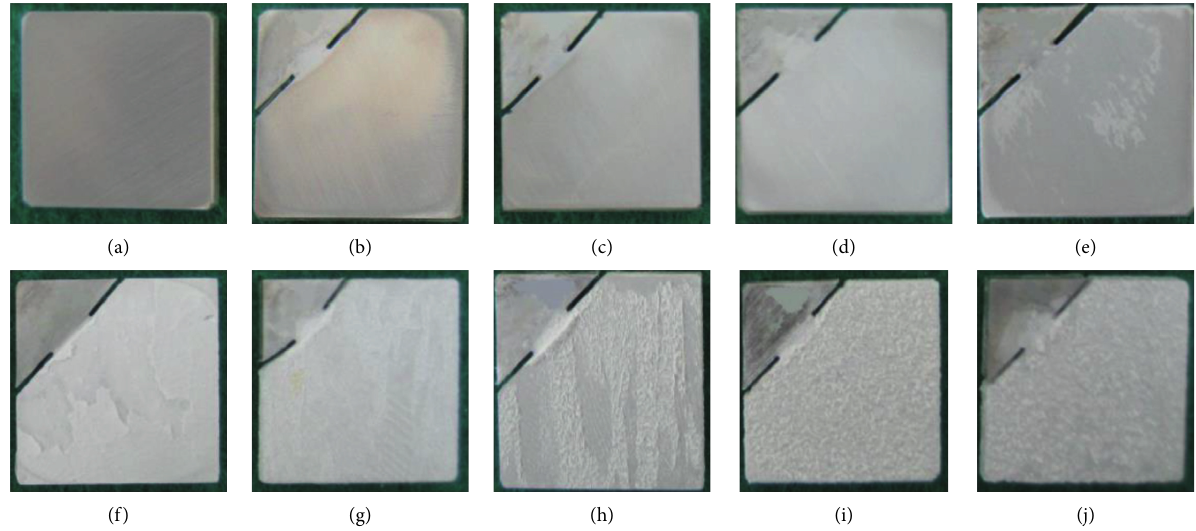
Figure 10: Optical observations of coated samples of (a) pure Mg, (b) AF10, (c) AF20, (d) AF30, (e) AF40, (f) AF50, (g) AF60, (h) AF70, (i) AF80, and (j) AF90